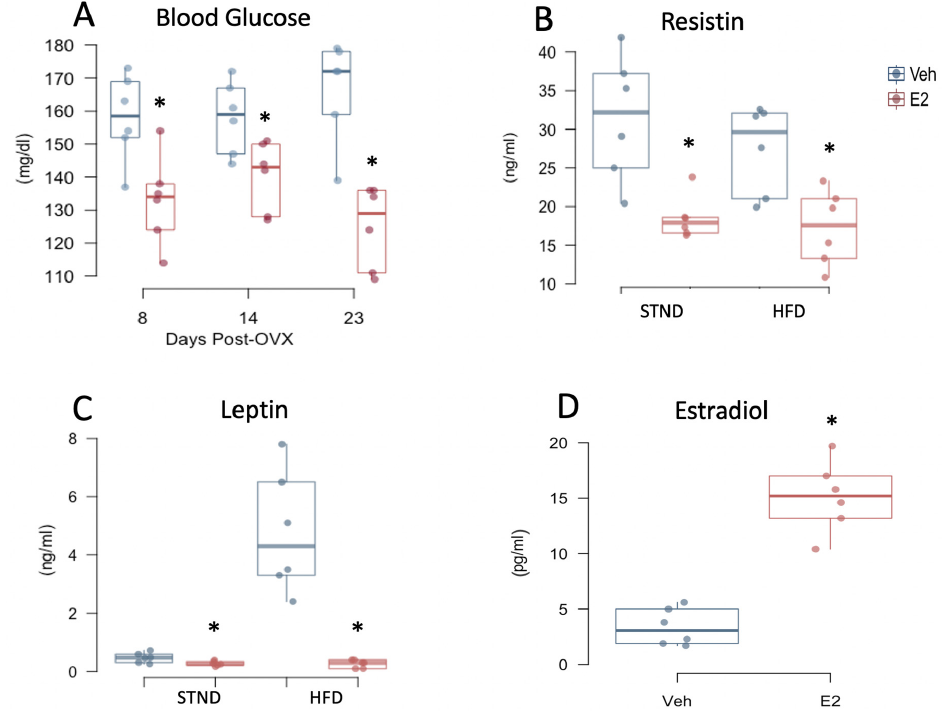
Figure 4. Estradiol decreases plasma glucose and adipokines in female mice independent of diet. 5 h-fasting blood glucose ( A ) on days 8 and 14, both during STND and on day 23, during HFD. Resistin ( B ) and leptin ( C ) were measured on D8 during STND and on D23 during HFD. Plasma estradiol levels were measured on D23 to confirm physiological levels in the treatment group ( D ). * indicates differences between E2 and Veh mice ( n = 6/group) ( p < 0.05, repeated measures ANOVA followed by t -test for A, B, and C, and t -test for